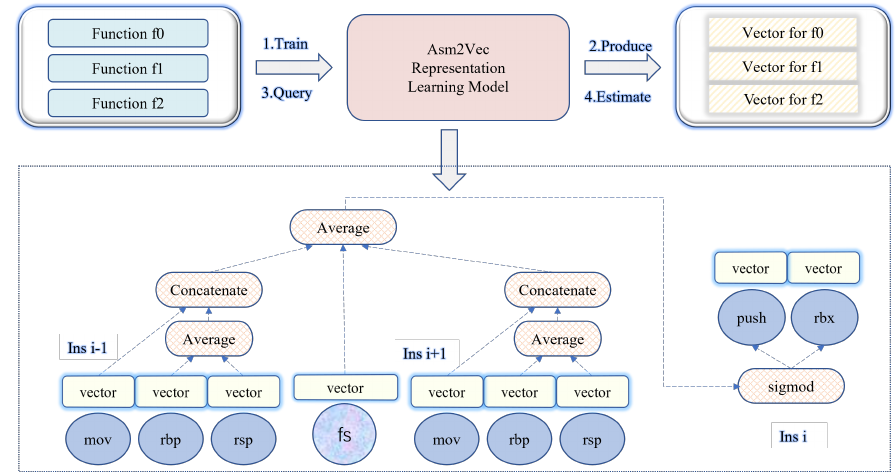
Figure 2. Function embedding